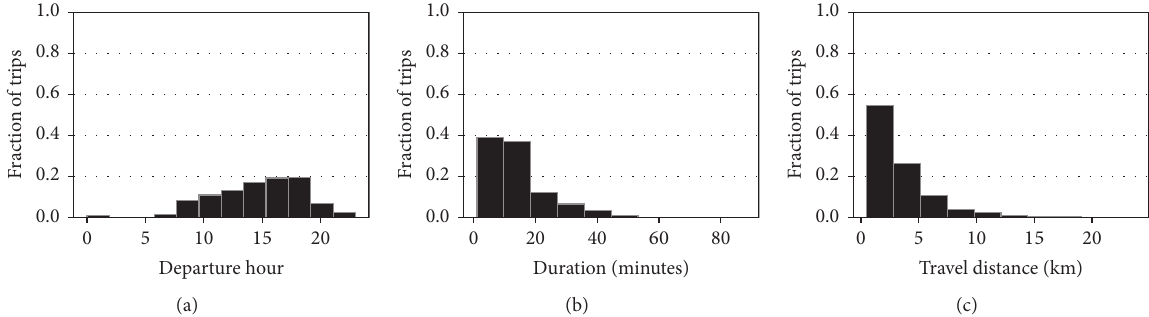
Figure 24: Attributes of the unique car trips that consistently have low-carbon time-relevant alternatives, illustrated by histograms.